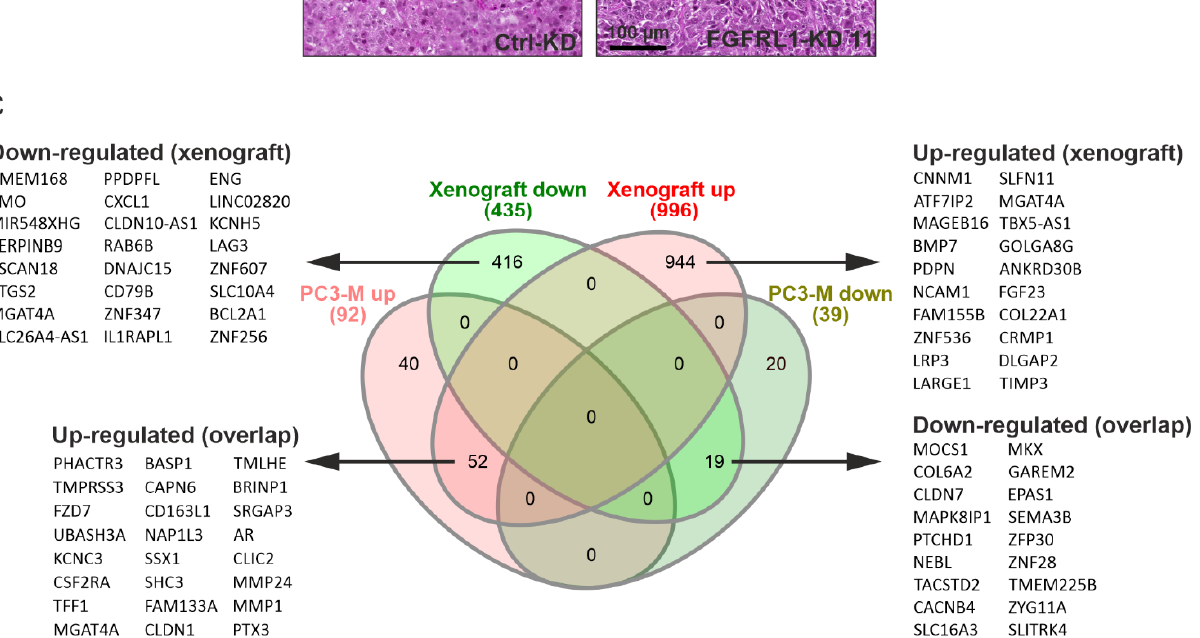
Figure 5. Growth and gene expression analysis of PC3M FGFRL1-KD and control-KD xenografts. ( A ) Growth of the cells as subcutaneous xenografts and body weight of mice bearing the tumors (* p < 0.05, student’s t-test for each time point, n = 10 for each group). ( B ) HE-stained histological sections of a representative xenograft of control-KD (ctrl-KD) and FGFRL1-KD (FGFRL1-KD11) groups. ( C ) Analysis of differential gene expression after shRNA-mediated FGFRL1 knockdown in PC3M cell line and mouse tumor xenografts generated from PC3M cells, in comparison to corresponding control cells/tumors. Venn diagrams show genes altered with a fold change > 2-fold with FDR of < 0.001. Core genes in xenograft data and overlapping between cell line and xenograft data are listed beside the